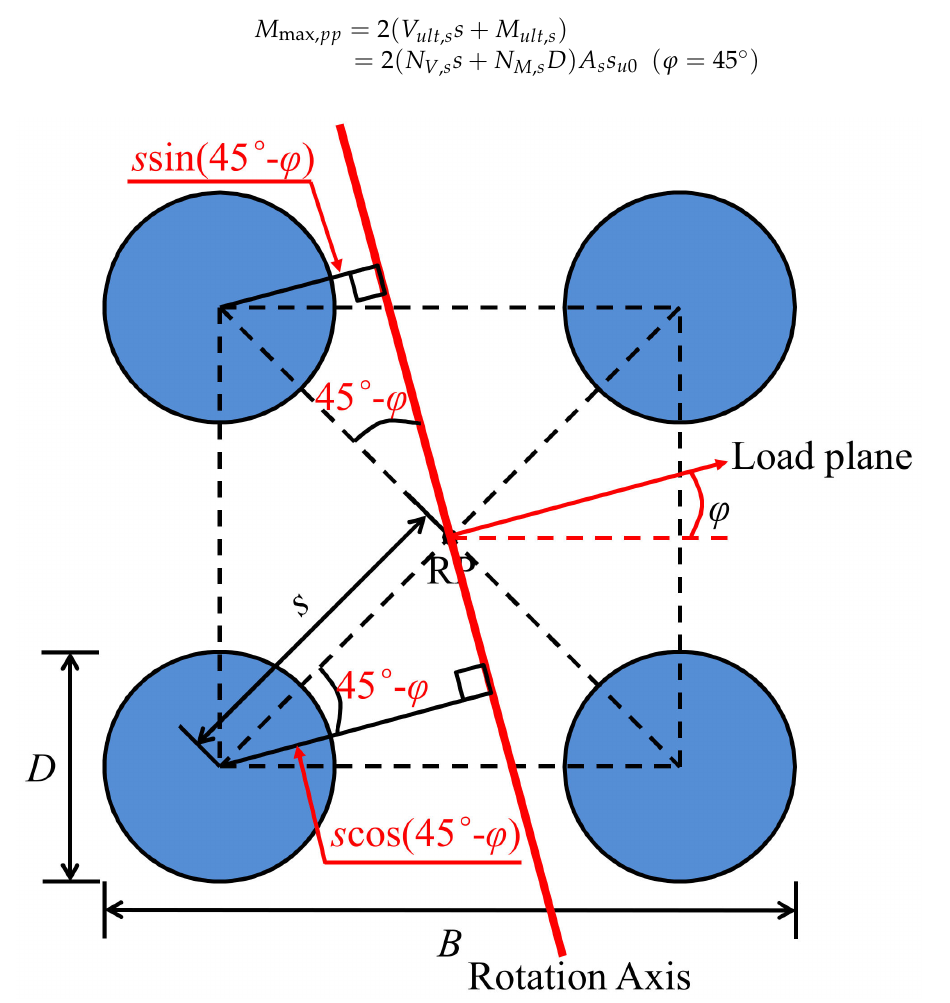
Figure 17. Diagram of tetrapod bucket foundations illustrating calculation of moment capacities in push–pull failure